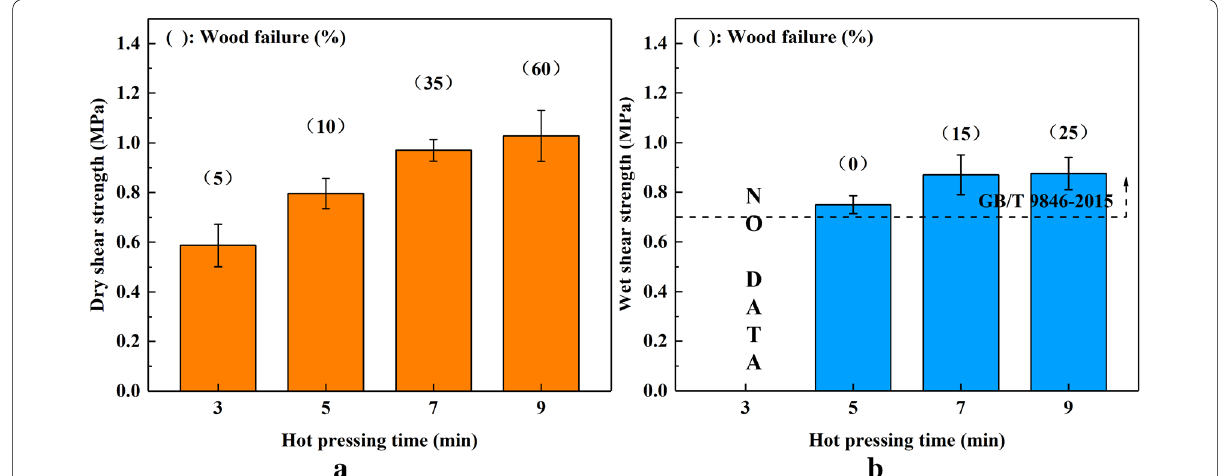
Fig. 4 Effects of the hot pressing time on the a dry and b wet shear strength of the plywood bonded by EHADP